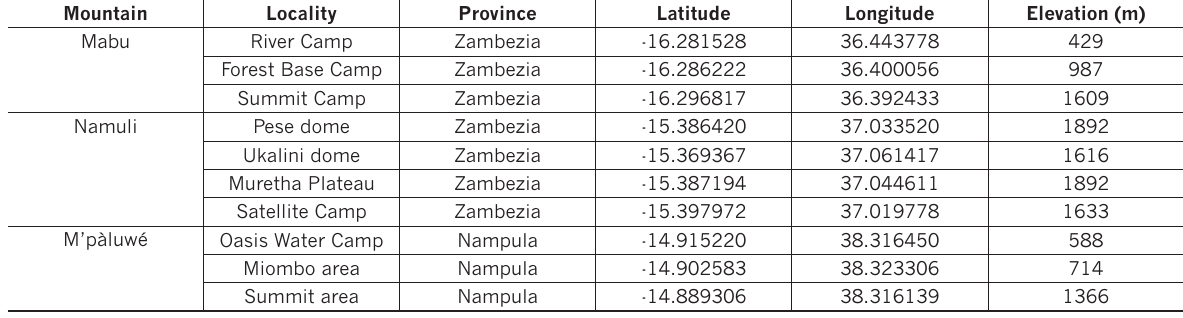
Table 1. Localities surveyed in northern Mozambique.